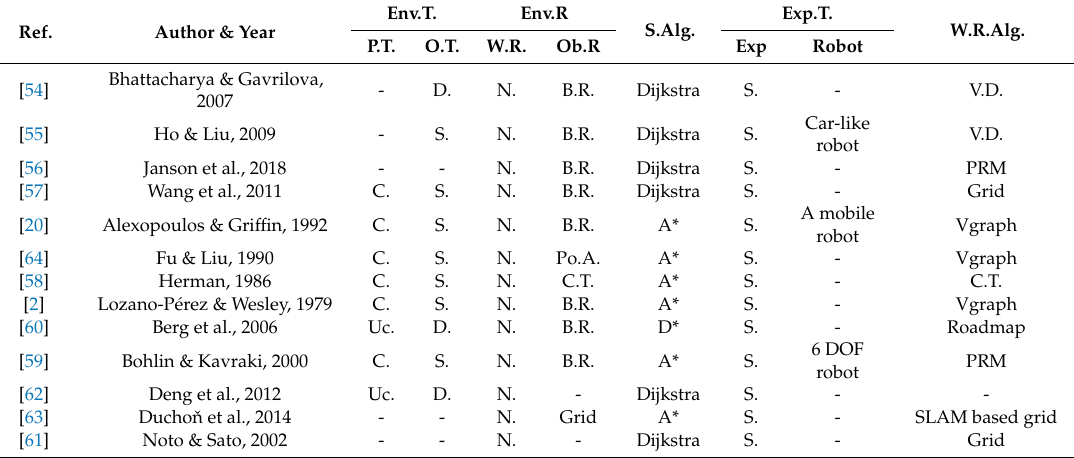
Table 3. Classification of the papers using the exact